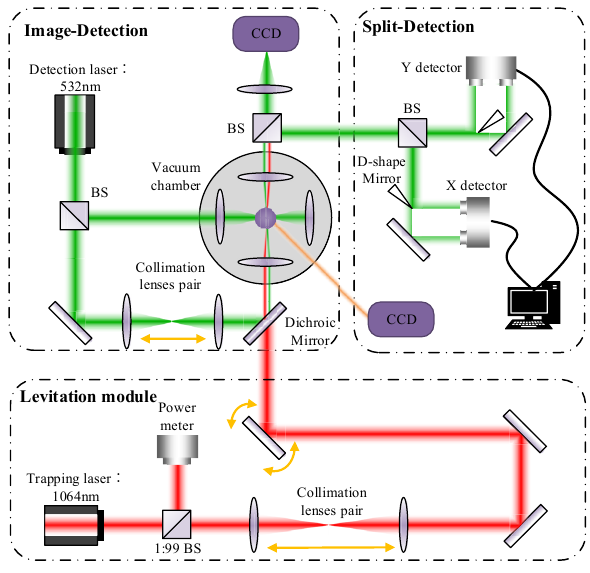
Figure 1: The optical setup used for the trapping and orbiting of a levitated particle in vacuum